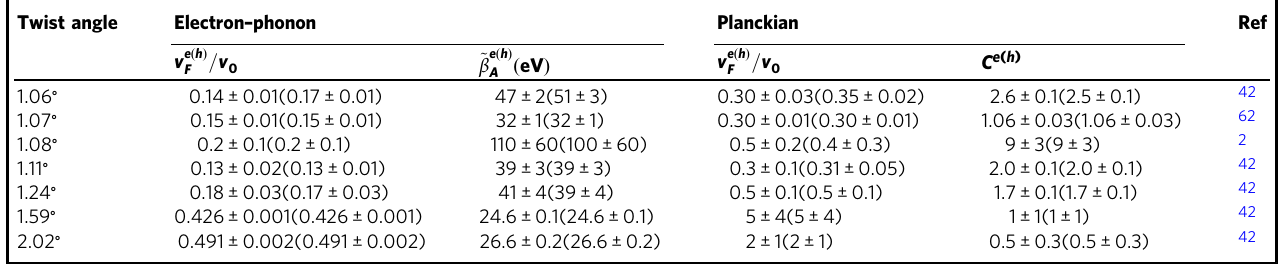
Table 1 Fitting parameters for the resistivity fi t to the electron – phonon and Planckian theory. The parameters are Fermi velocity ( v F ) and electron – phonon gauge coupling ð Planckian theory.